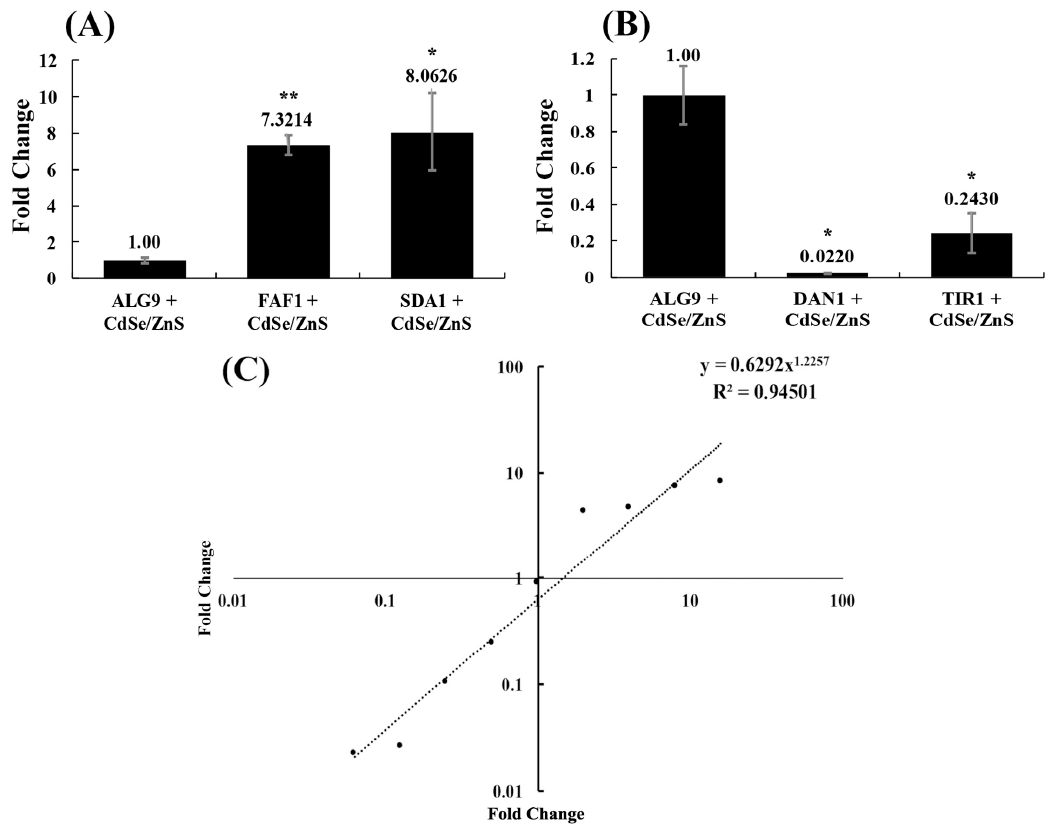
Figure 3. Fold-changes acquired through RT-qPCR. Two up and downregulated genes chosen from our RNA-seq experiments were compared to a housekeeping gene ( ALG9 ) found to not be differentially expressed when exposed to CdSe/ZnS-QDs. The fold changes of the two up and downregulated genes were calculated from our RT-qPCR data by utilizing the Pfaffl equation. Fold changes were found with RT-qPCR to validate fold-changes obtained with our RNA-seq. ( A ) The fold changes of the upregulated genes ( FAF1 and SDA1 ) obtained with RT-qPCR. ( B ) The fold-changes of the downregulated genes ( DAN1 and TIR1 ) obtained with RT-qPCR. A student’s t -test results are represented with * ( p < 0.05), ** ( p < 0.01). ( C ) The fold change correlation represented by a trend line that shows the power regression line with the equation and R 2 value of 0.94501. The x and y-axes are in 2- base logarithmic scale, and fold-changes that are < 1 and > 1 correspond to down and upregulation,